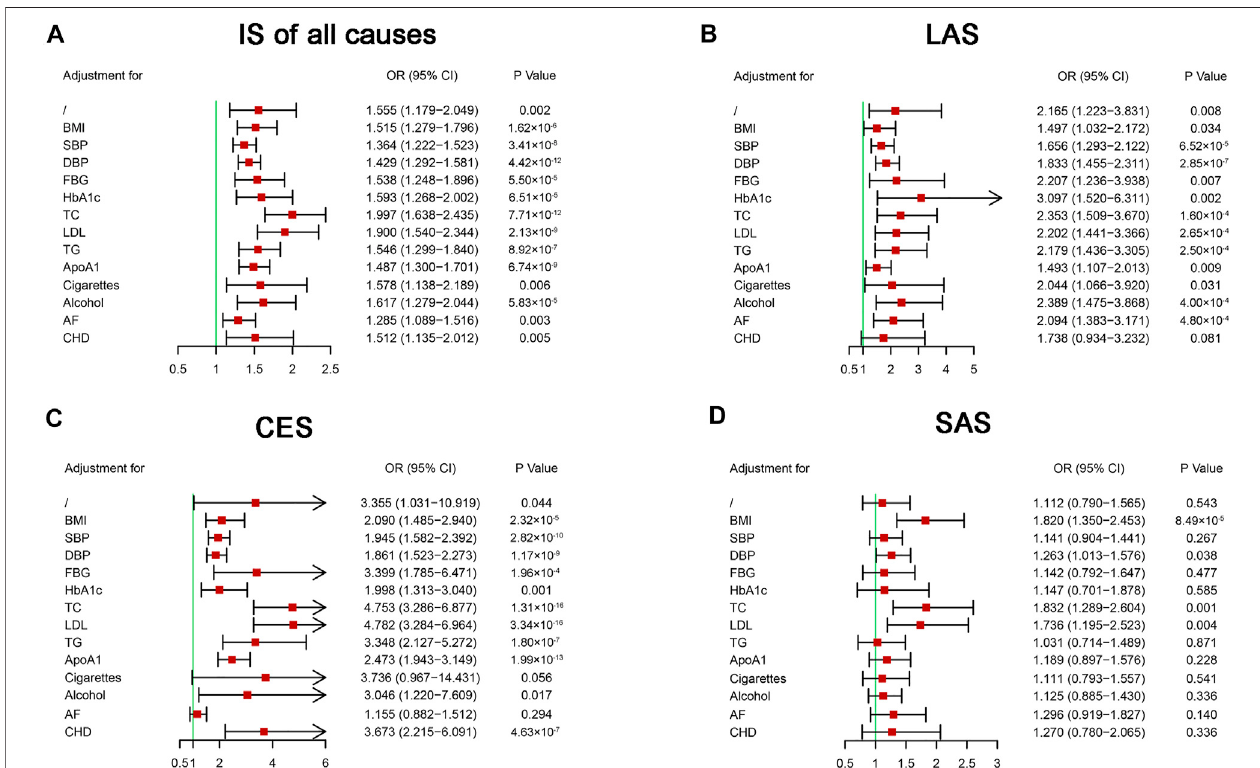
FIGURE 3 | Multivariable Mendelian randomization analysis of the effect of heart failure on ischemic stroke. ApoA1, apolipoprotein A-1; AF, atrial fi brillation; BMI, bodymassindex; CES,cardioembolicstroke;CHD,coronaryheartdisease;CI,con fi dential interval;DBP,diastolicbloodpressure;FBG, fastingblood glucose;HbA1c, glycosylated hemoglobin; IS, ischemic stroke; LAS, large artery atherosclerosis stroke; LDL, low-density lipoprotein cholesterol; OR, odds ratio; SAS, small artery occlusion stroke; SBP, systolic blood pressure; SNP, single nucleotide polymorphism; TC, total cholesterol; TG, triglyceride.